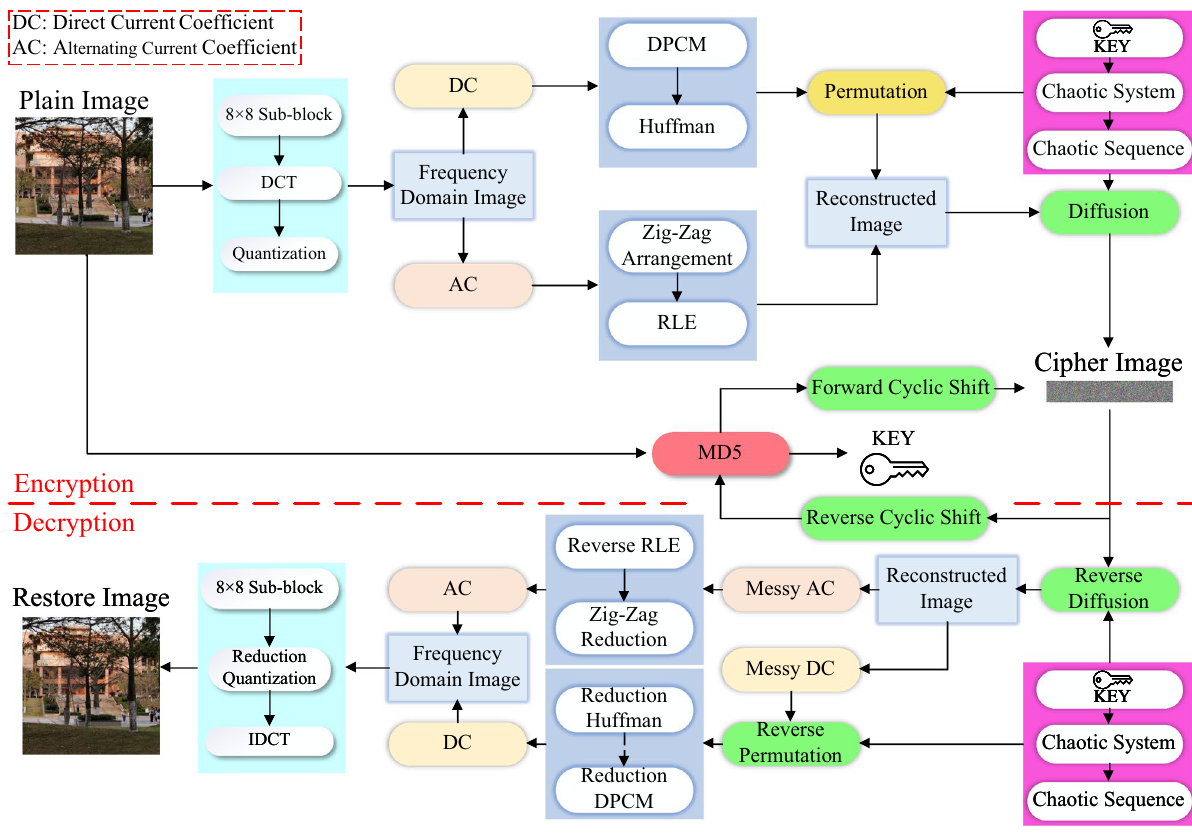
Figure 7. Principle and mechanism of image encryption.